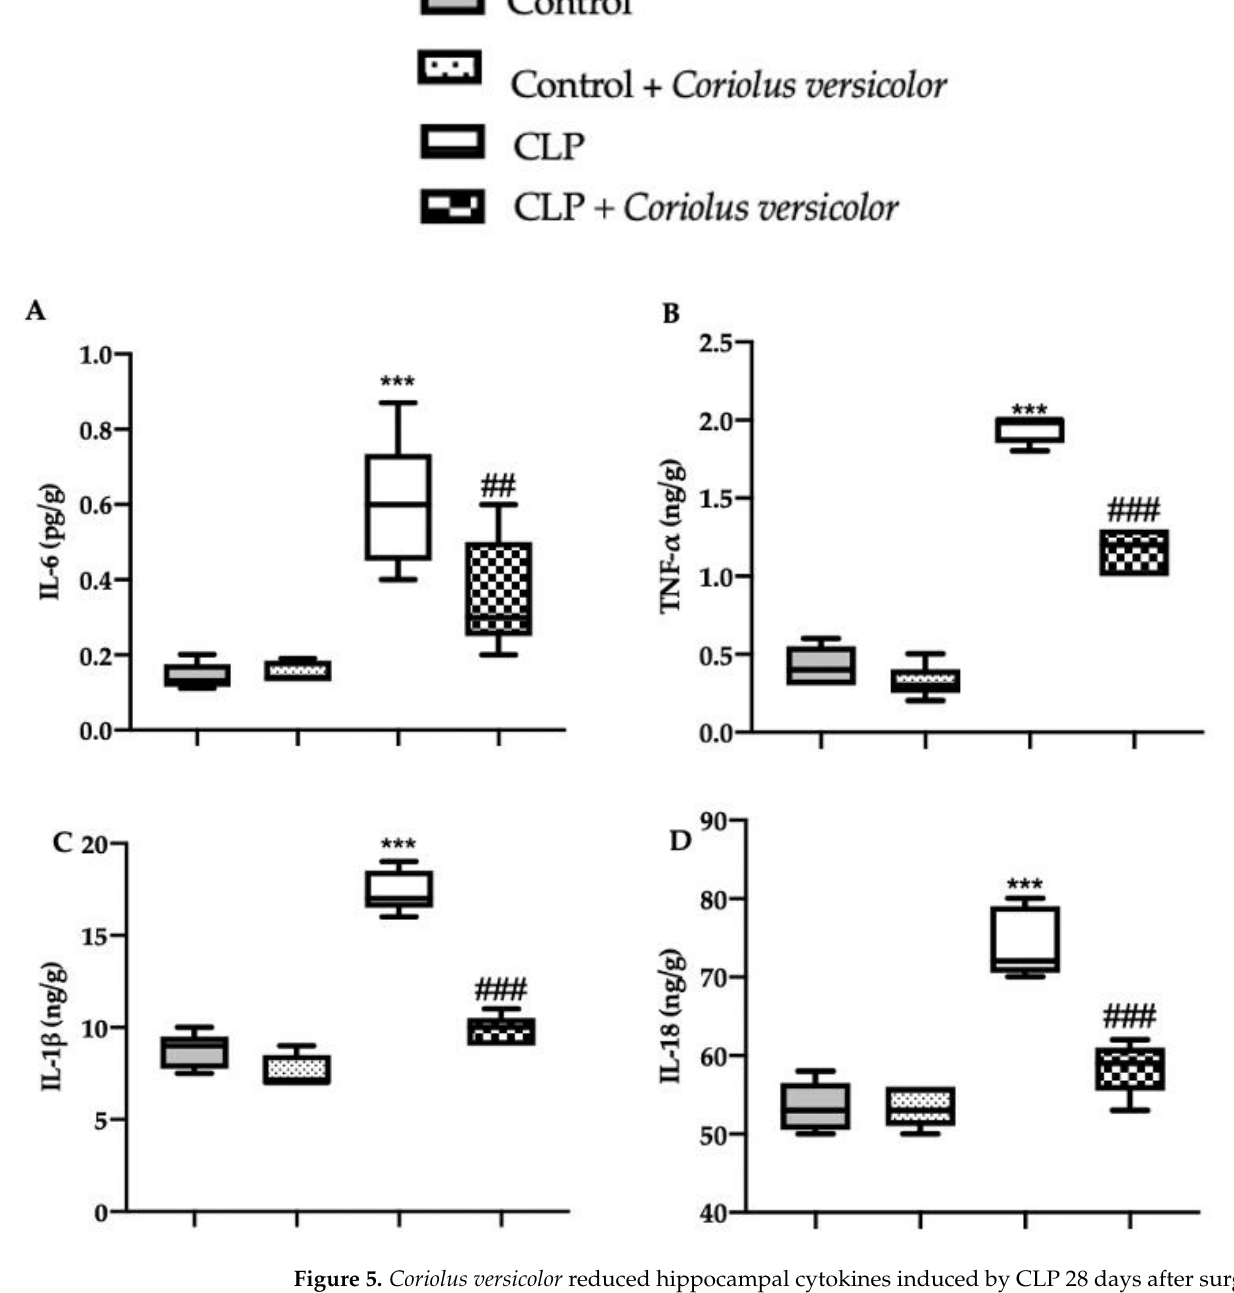
Figure 5. Coriolus versicolor reduced hippocampal cytokines induced by CLP 28 days after surgery. Levels of hippocampal interleukin (IL)6 ( A ), tumor necrosis factor (TNF)- α ( B ), IL-1 β ( C ), IL18 ( D ). ## p < 0.01 vs. CLP, *** p < 0.001 vs. control, ### p < 0.001 vs. CLP.